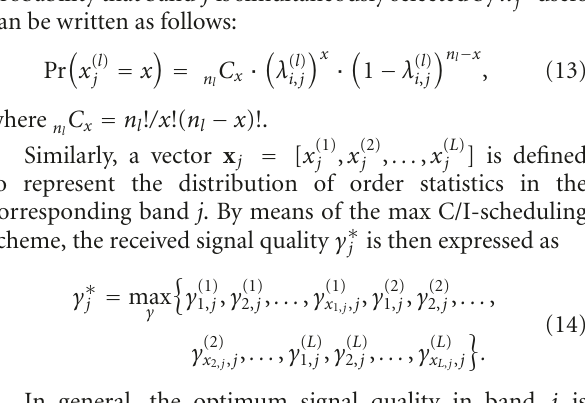
Table 1: Basic OFDMA system